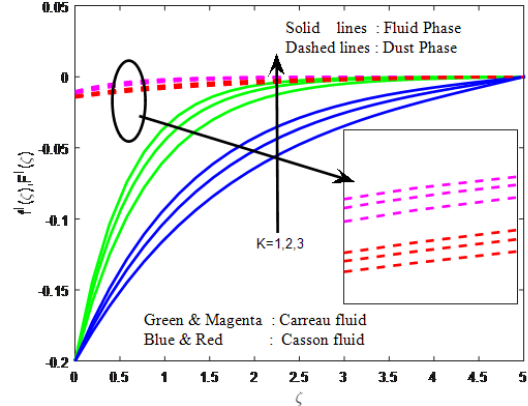
Fig. 11: Impact of K on velocity profiles.